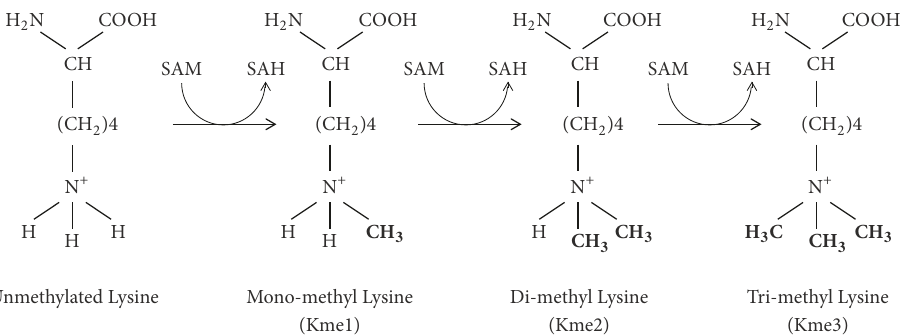
Figure 13: Formation of mono-, di-, and